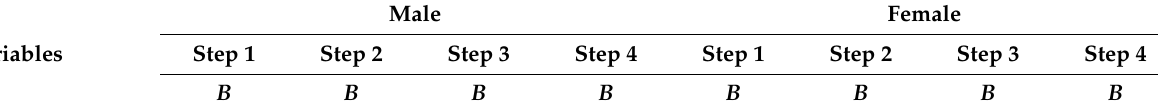
Table 2. Hierarchical multiple linear regression on positive affect by associated psychosocial and health-related factors in the 15–18 y age group based on